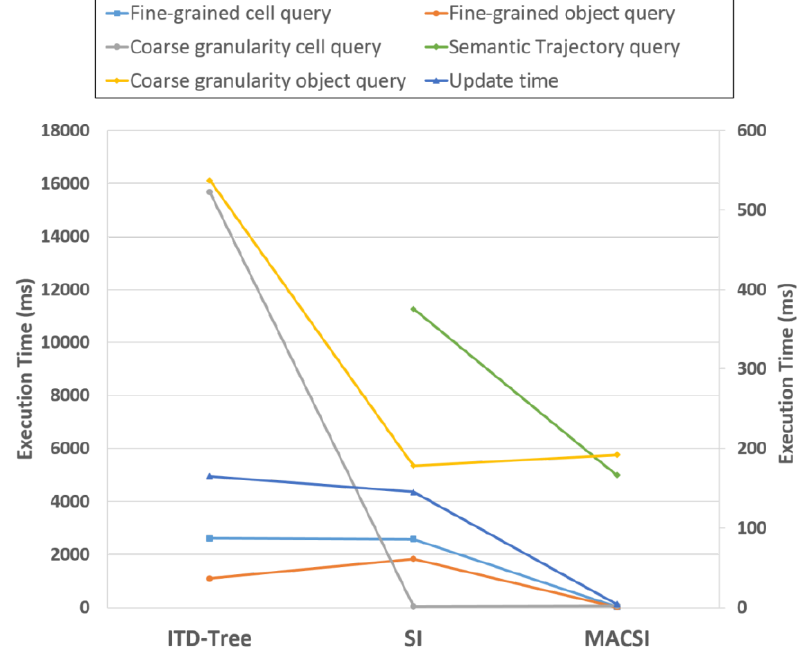
Figure 32. Real dataset result. (ITD-Tree, Si and MACSI are distributed in the abscissa axis, respectively. It is obvious that the overall trend of the system response time is ITD-Tree > SI > MACSI. Additionally, MACSI showed better performance than ITD-Tree and SI in semantic cells, and objects’ queries as well as updates).